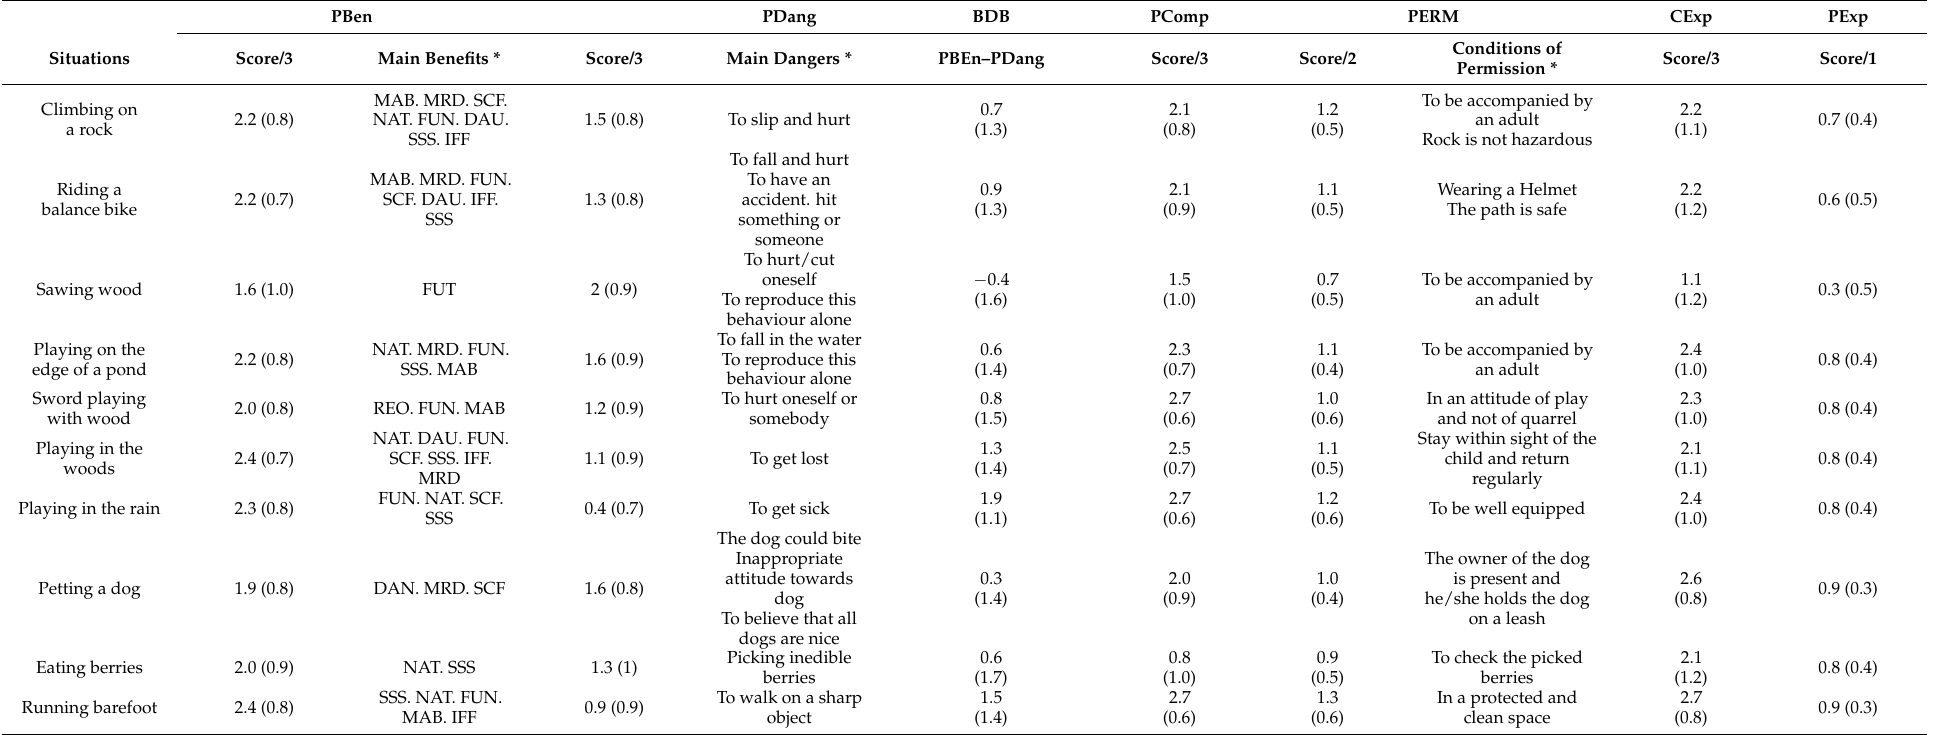
Table 3. Descriptive analysis (mean score (standard deviation)) for perceived benefits (Pben), perceived dangers (Pdang), benefits/dangers balance (BDB), perceived competences (PComp), permission to play (PERM), child experience (CExp), parent experience (PExp), and main benefits, dangers, and permission conditions reported by